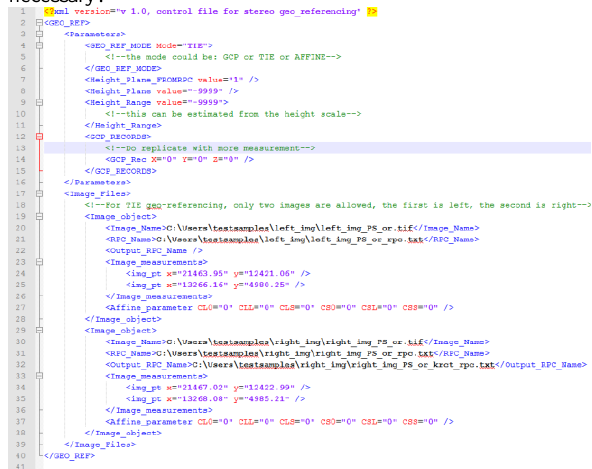
Figure 3. An example of a control file for